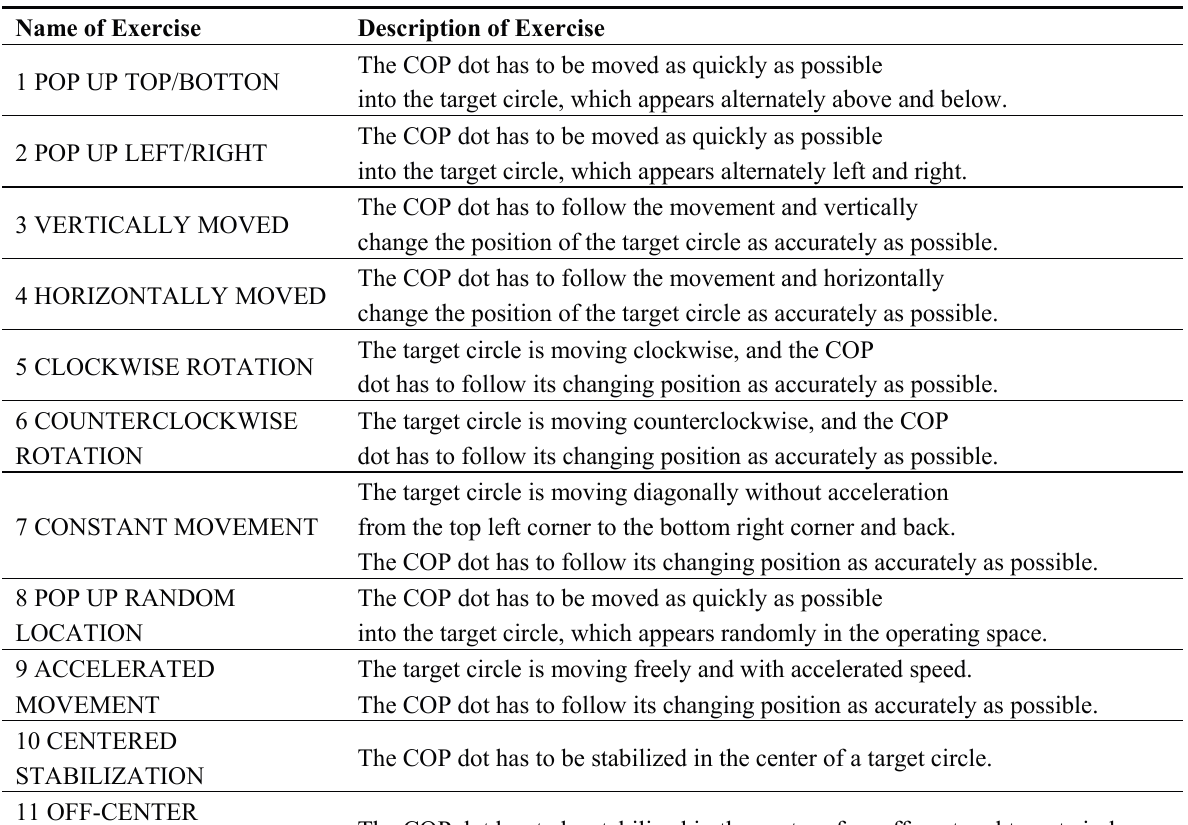
Table 1. Exercises of the Active Balance